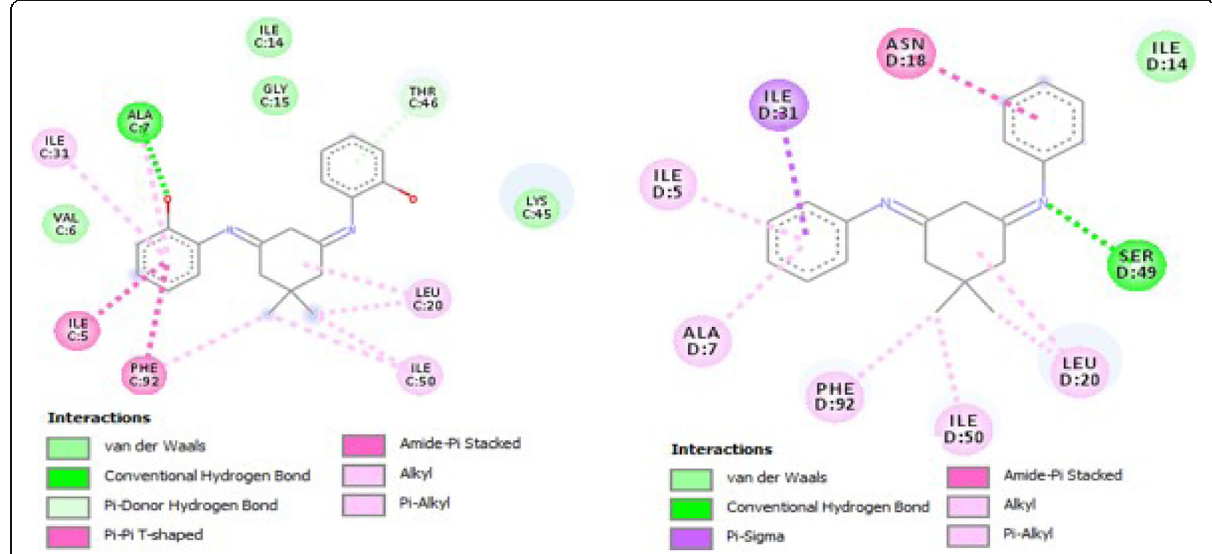
Fig. 4 2D interaction diagrams of a DmChDp in site 3 of 2W9S and b DmChDa in site 2 of